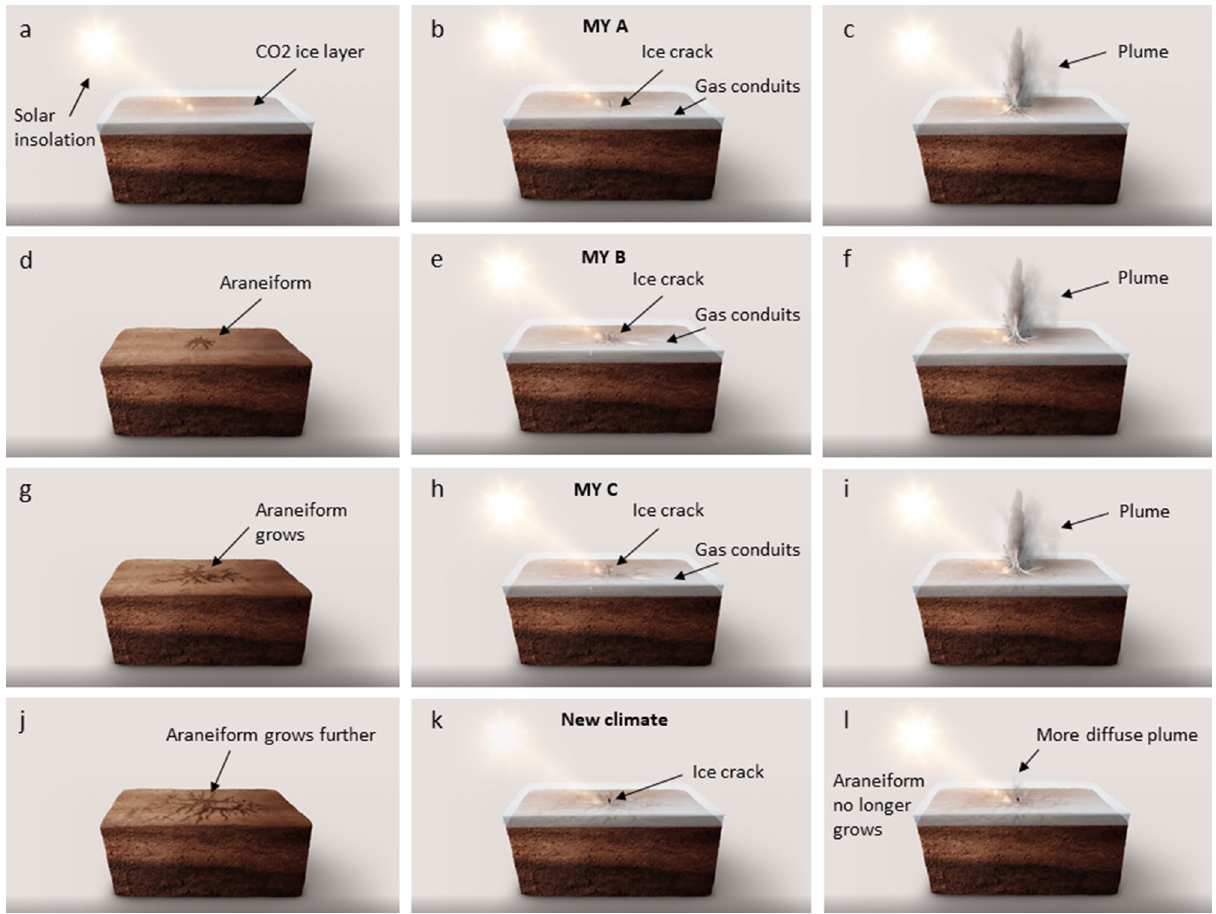
Figure 8. Araneiform development hypothesis suggesting araneiforms formed in a paleoclimate and their activity today is not growing existing radial araneiforms. ( a – d ) Show initial araneiform development as suggested by Kieffer and Piqueux 3, 9 . ( e – j ) However we suggest that a radial structure develops initially and grows each MY during this paleoclimate which is conducive to more energetic cryoventing. ( k , l ) Show the present day Martian climate where fans and spots still reappear, however we suggest the terrain is not eroded and fans and spots are recycled dust transported by a much more diffuse plume than in ( c , f , i ). Source: Collaboration between Wax Visuals and LEM. Wax visuals created the artistic representation of the araneiform development